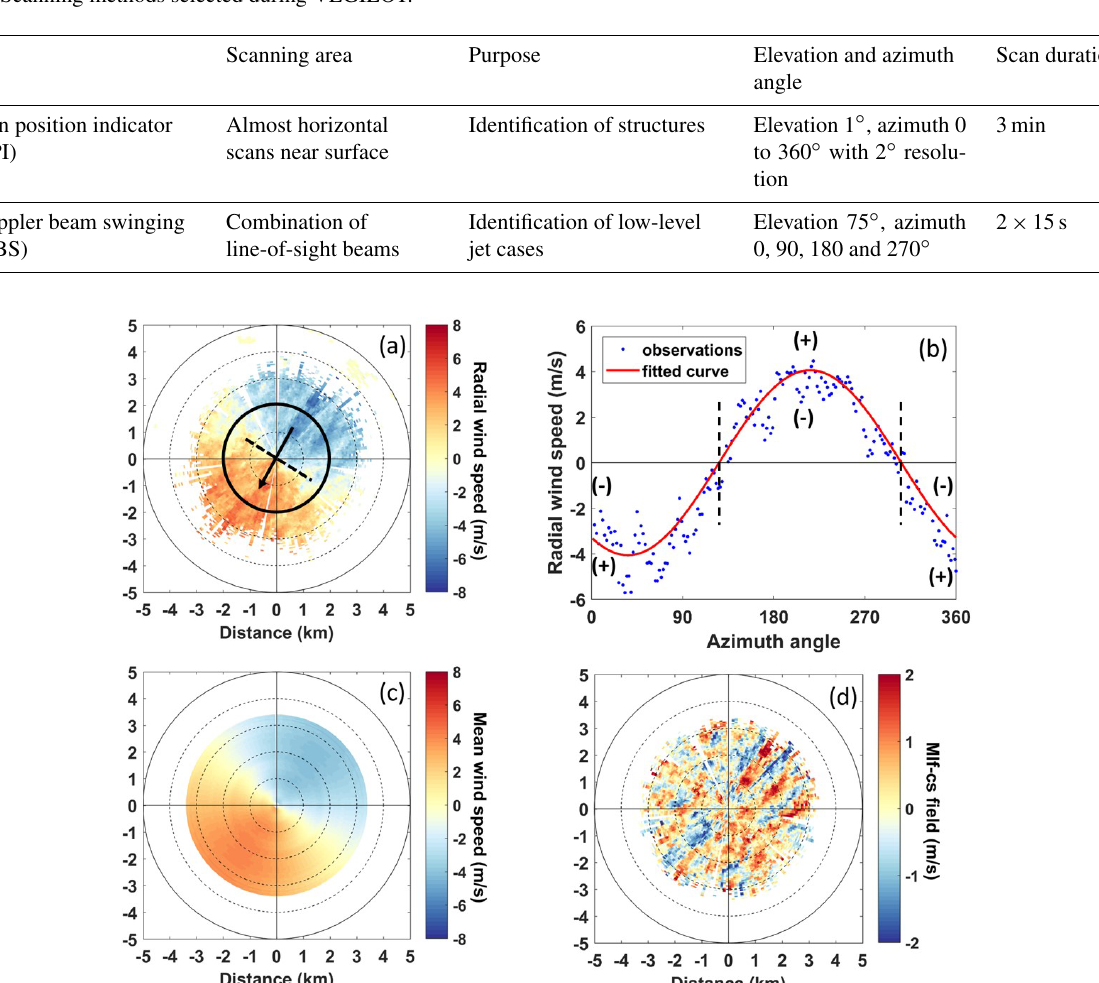
Figure 3. Observations recorded during a quasi-horizontal PPI scan on 8 September 2014 at the Jussieu site, Paris, at 09:26UTC. (a) Radial wind speed along with the mean wind direction (black line) and the transverse direction perpendicular to it (black dotted line). (b) Radial wind speed (blue dots) as a function of the azimuth angle at a fixed 2km distance from the lidar (black circle on a ) along with the cosine fit function (red line). (c) Mean wind speed projected on the beam direction. (d) The mlf-cs